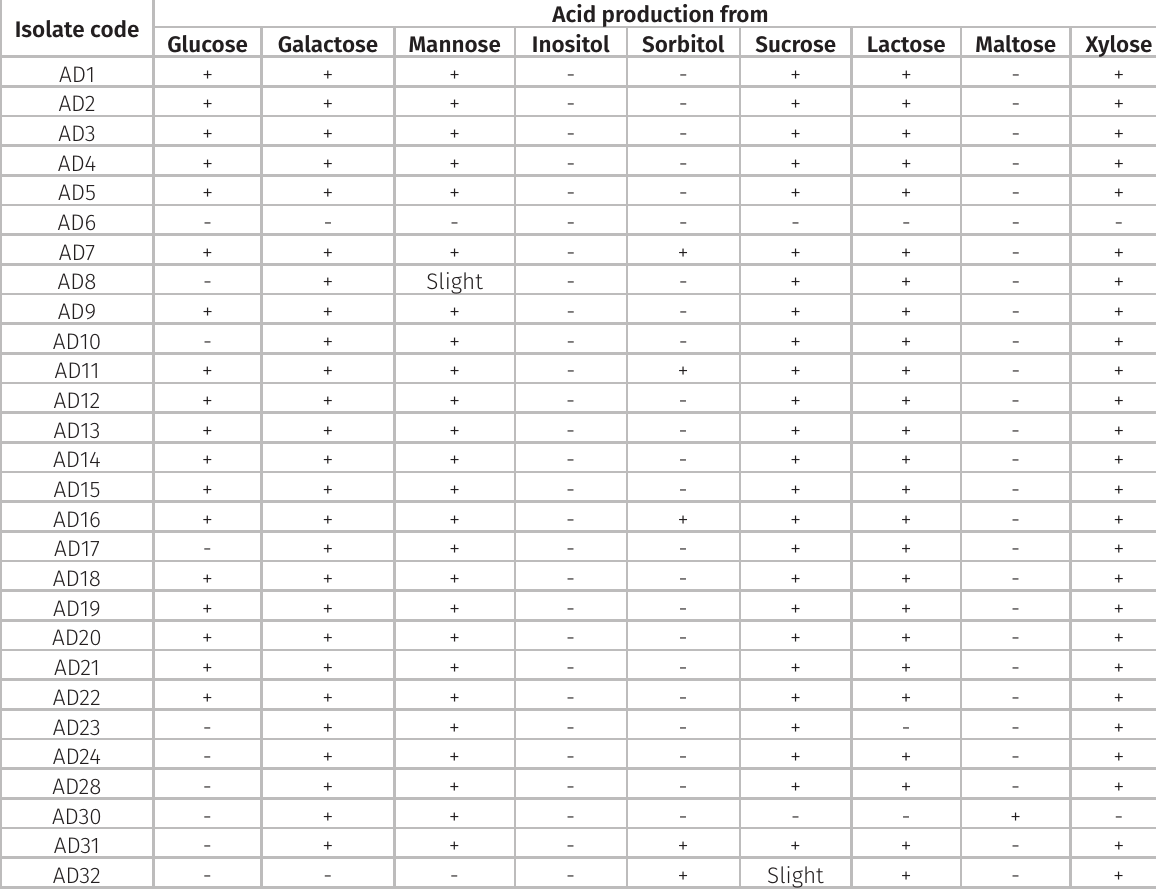
Table III. Phenotypic characteristics (acid production from various sugars) of the isolates. Acid production from Isolate code Glucose Galactose Mannose Inositol Sorbitol Sucrose